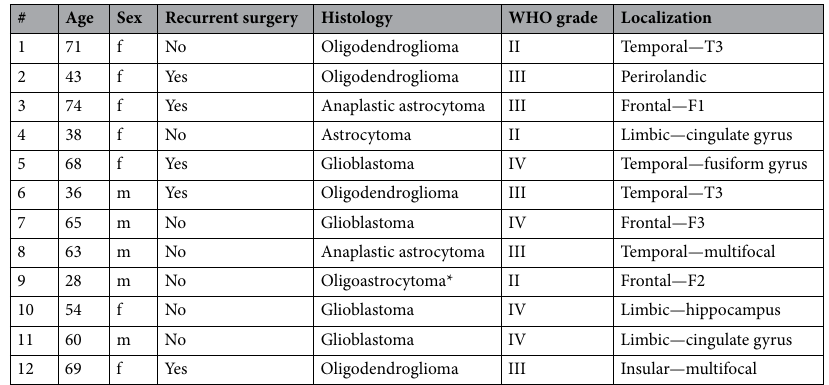
Table 1. Case series characteristics. # patient number, f female, m male, WHO World Health Organization, CNS central nervous system, T3 inferior temporal gyrus, F1 superior frontal gyrus, F3 inferior frontal gyrus, F2 middle frontal gyrus. *Resection and histological diagnosis before revised 2016 CNS WHO